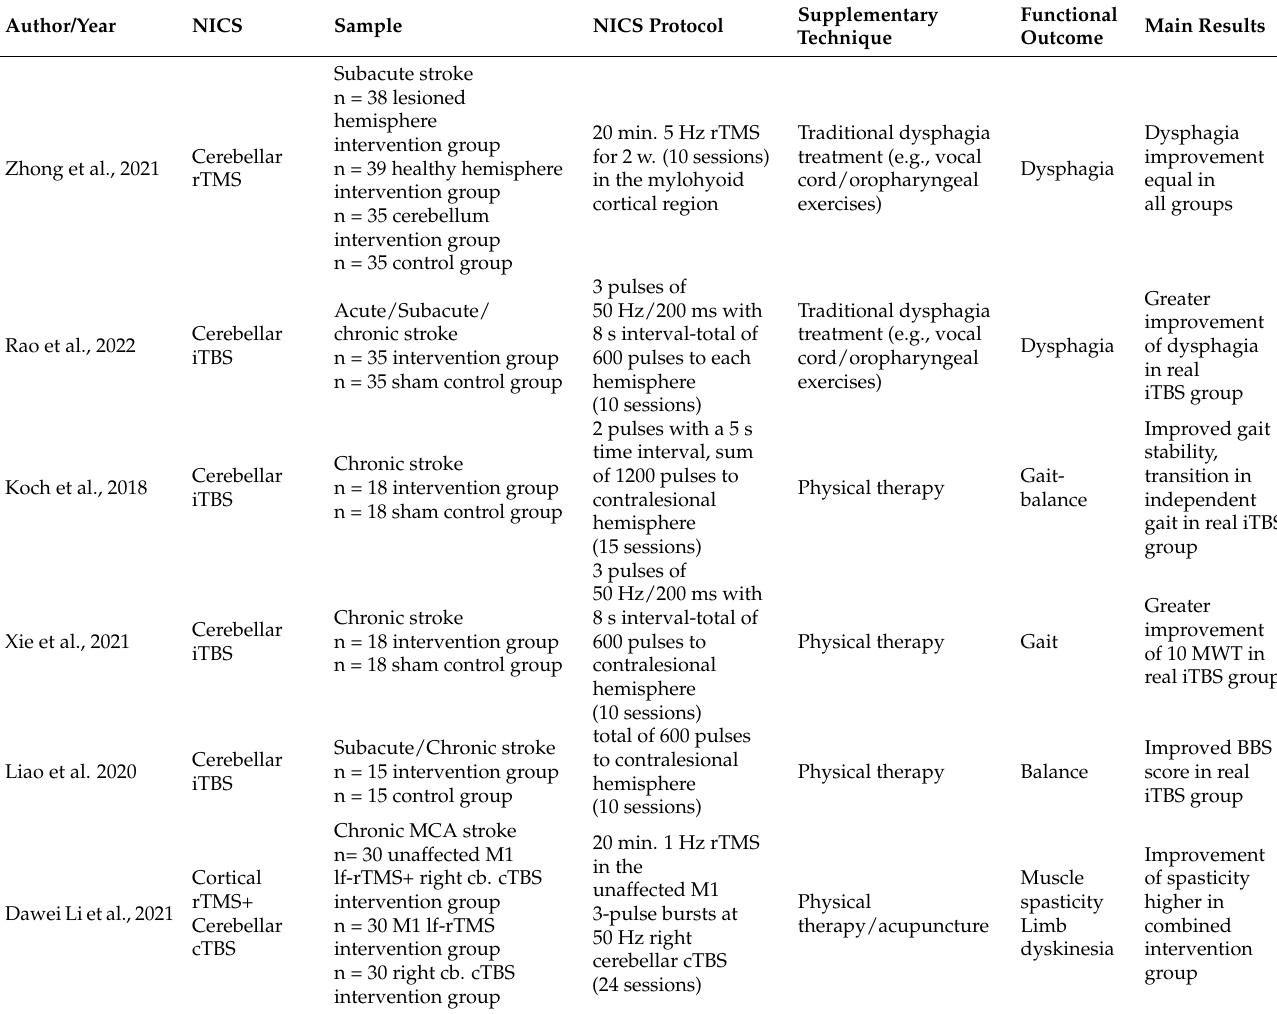
Table 1. Clinical studies concerning cerebellar TMS applications in stroke